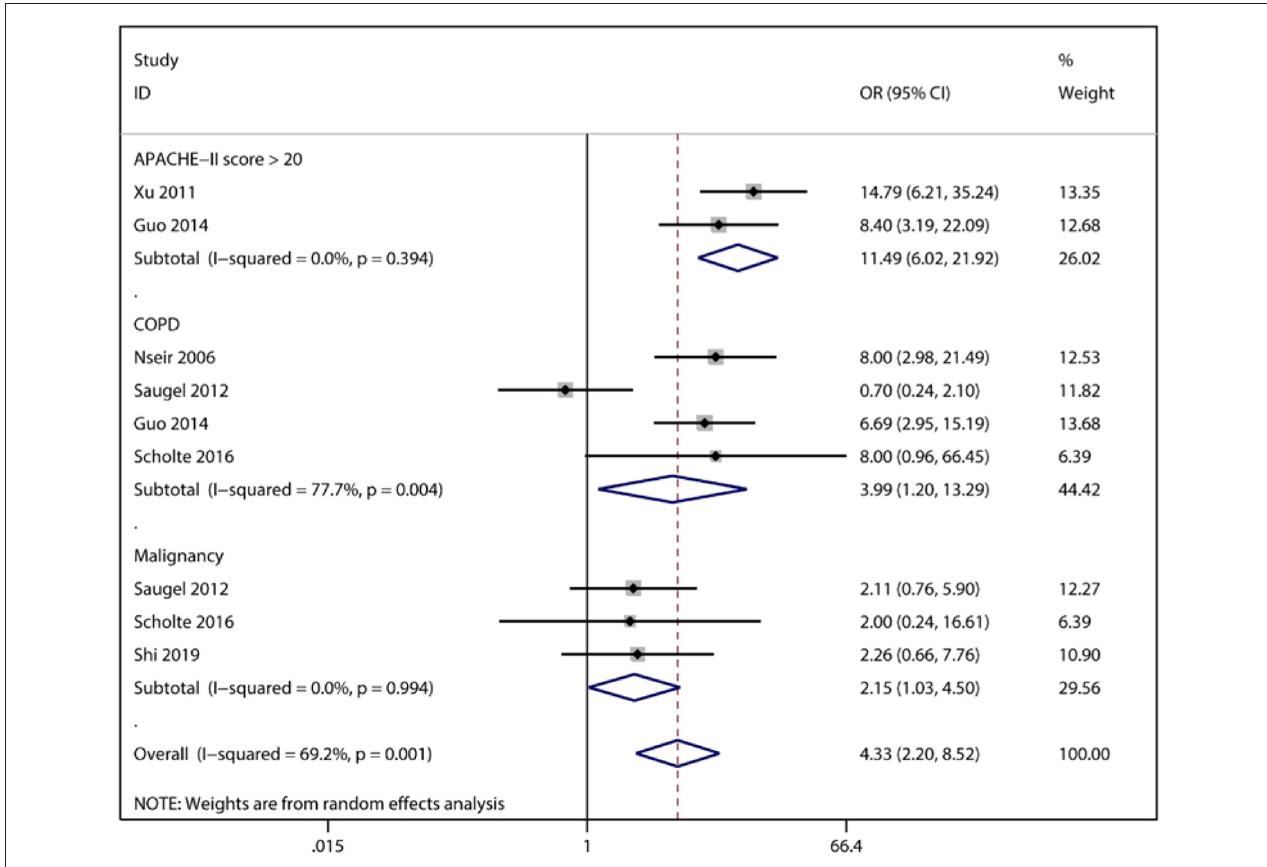
FIGURE 2 | Meta-analysis results of impact of general condition and combined underlying diseases on risk factors for acquired Stenotrophomonas maltophilia in intensive care unit.